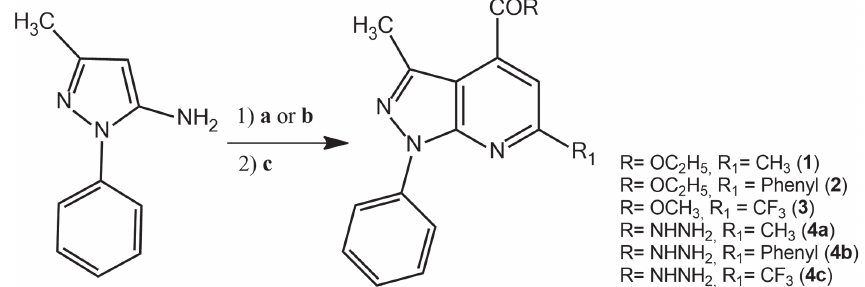
Figure 1 - Reagents and conditions: ( a ) Ethyl 2,4-dioxovalerate or ethyl-2,4-dioxobutanoate, reflux, furnished ( 1-2 ) in 90% yield; ( b ) Sequence of reactions involving: ethyl 4,4,4-trifluroacetoacetate; Dowtherm A; POBr furnished ( 3 ) in 80 % yield; ( c ) NH 94% yield.